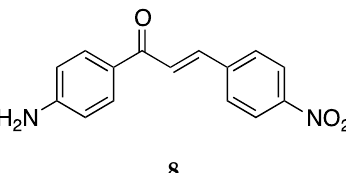
Figure 10. Chemical structures of 4-aminochalcone derivatives with nitro substitution on ring B. The cytotoxic activity for 8 was tested against many different cancer cell lines (Table 7). Table 7. Inhibitory effect of compound 8 against the human Molt 4/C8, CEM T-lymphocytes, murine P388, L1210, human colon cancer HT-29, LS180, LoVo, and LoVo/DX cell lines.